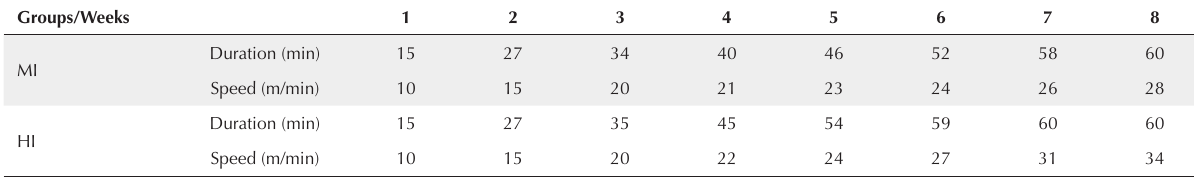
Table 2 . Moderate and high-intensity aerobic exercise protocol on treadmill Groups/Weeks